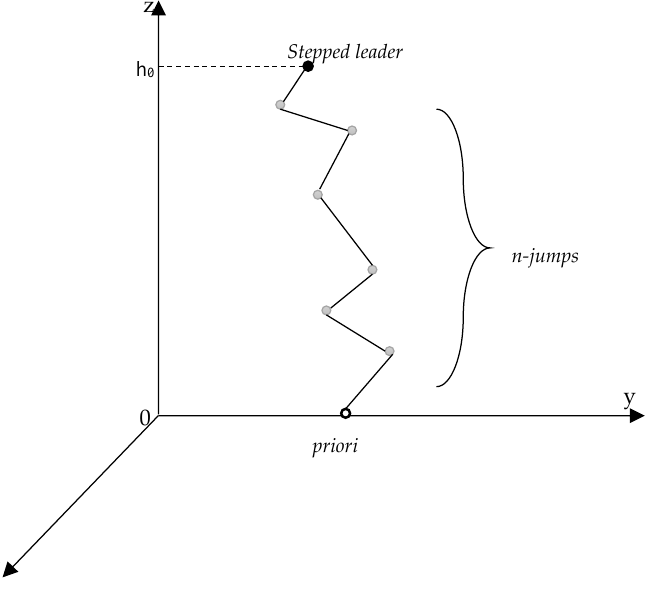
Figure 3. Simulating n jumps of lightning strike stepped leader head.